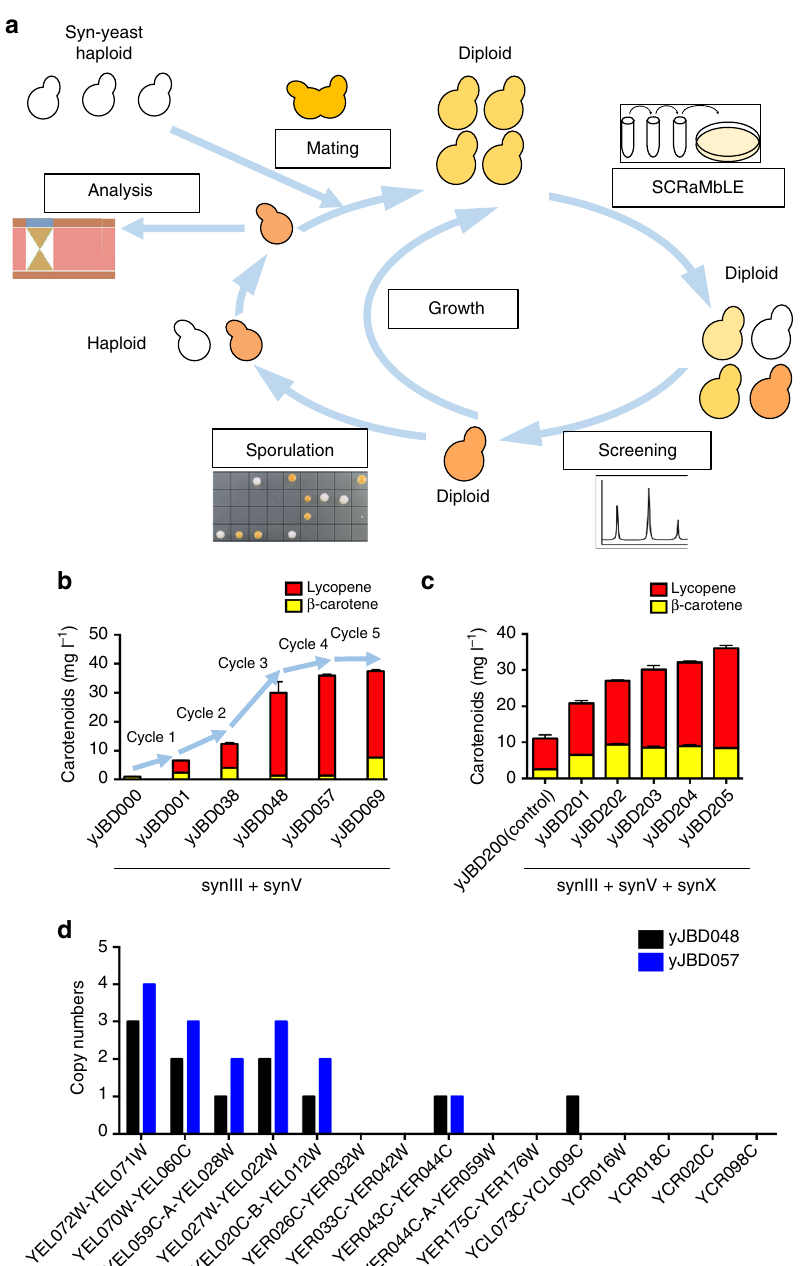
Fig. 5 MuSIC strategy for rapid evolution. a MuSIC enables the generation of chromosome diversity across a large population of cells through the iterative SCRaMbLEing and screening of yeast. Based on step-by-step screening and accumulation analysis, cells with improved production are then recovered for the subsequent cycle. High-production diploids are dissected to screen for high-level production spores. The spores are capable of mating with other synthetic haploid yeast for subsequent cycles. b Five cycles of MuSIC to screen for high-production diploids. The yJBD001, yJBD038, yJBD048, yJBD057, and yJBD069 strains were generated by SCRaMbLEing the yJBD000, yJBD001, yJBD038, yJBD048, and yJBD057 strains, respectively. c Incorporation of multiple synthetic chromosomes for SCRaMbLE. The spore from dissection of yJBD001 was mated with synX yeast haploids for the subsequent cycle